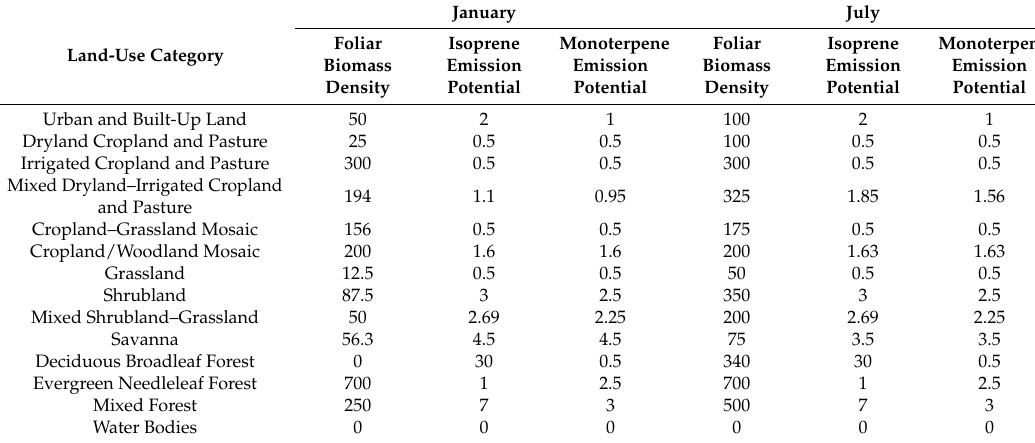
Table 1. Foliar biomass densities (g dry weight foliage m − 2 ) and emission potentials ( µ g g − 1 h − 1 ) for the observed land-use categories in Greece for the months of January and